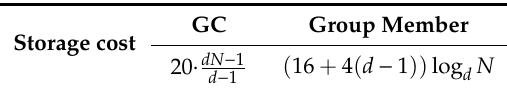
Table 4. CEGKD storage